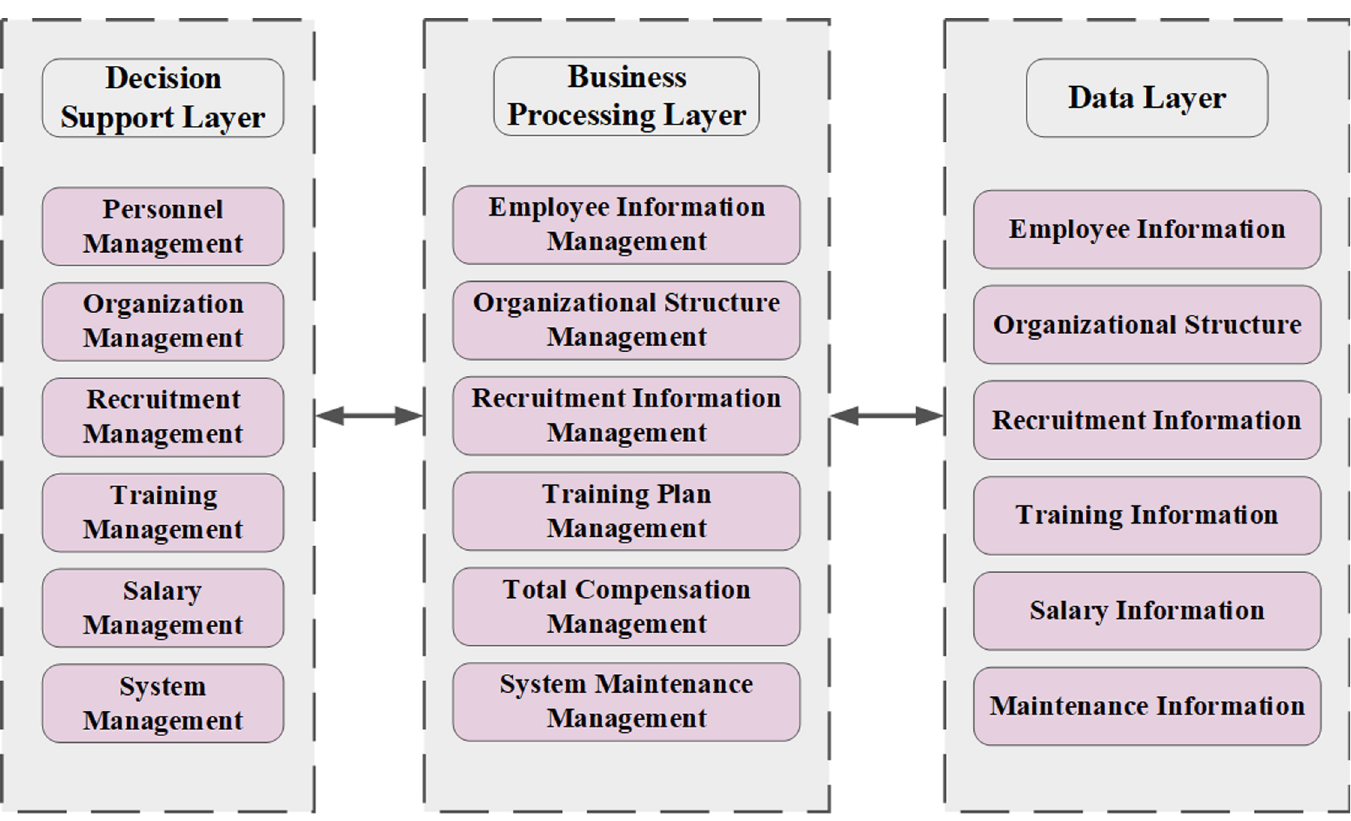
Fig 9. Logic of the